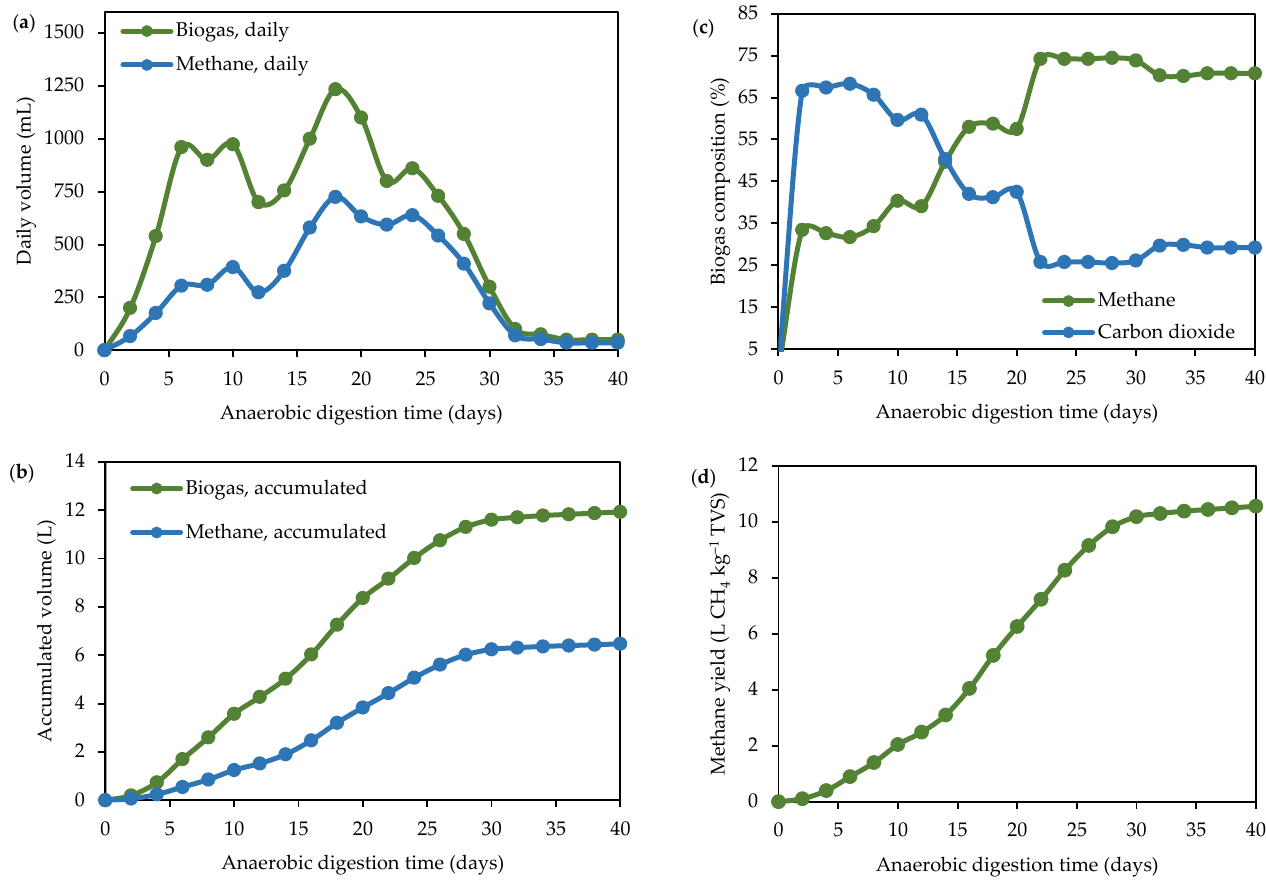
Figure 3. Biogas and methane produced from dry AD of BSG. ( a ) Daily volume of biogas and methane; ( b ) accumulated volume of biogas and methane; ( c ) biogas composition; ( d ) methane yield.